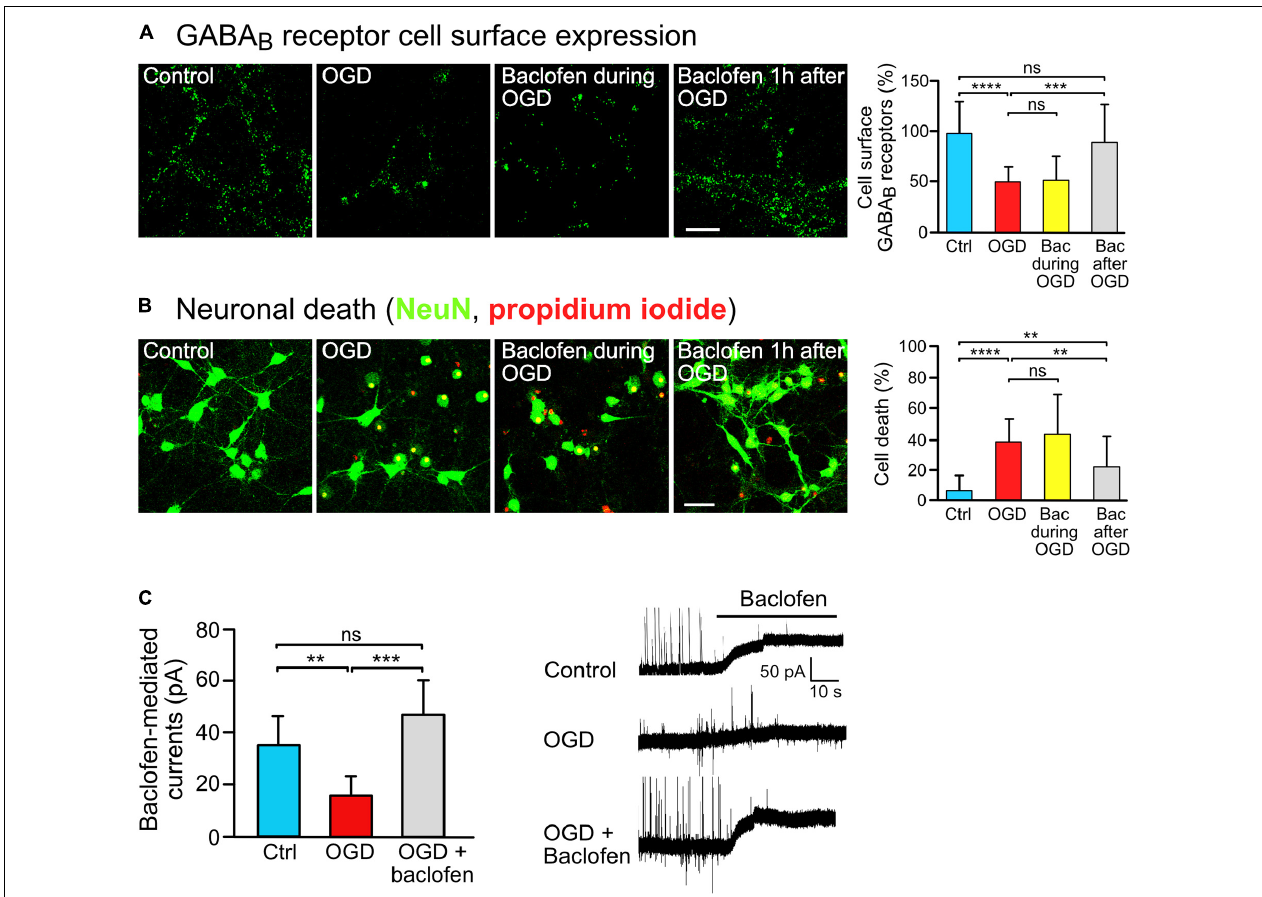
FIGURE 1 | Baclofen treatment restored GABA B receptor surface expression and was neuroprotective after OGD stress in vitro . (A) Baclofen treatment after, but not during, OGD increased GABA B receptor cell surface expression. Cultures were treated with baclofen (50 µ M) during or after OGD. After 16 h after OGD, neurons were then analyzed for the level of GABA B receptor surface expression using antibodies directed against GABA B 2 . The incubation time with baclofen was 1 h in the “Bac during OGD” condition and 16 h in the “Bac after OGD” condition. Left, representative images (scale bar, 10 µ m). Right: the bar graph depicts the quantification of fluorescence intensities. The data represent the mean ± SD of 18–23 neurons per condition from two independent experiments. One-way ANOVA followed by Tukey’s Multiple Comparison test (ns, p > 0.05; ***, p < 0.001; ****, p < 0.0001). (B) Treatment with baclofen after, but not during, OGD reduced neuronal loss in vitro . Cultures were treated as in panel (A) and neuronal loss was determined using propidium iodide (red) and NeuN staining (green) 24 h after OGD. Left, representative images (scale bar, 40 µ m). Right: the bar graph depicts the quantification of fluorescence intensities. The data represent the mean ± SD of 40–41 neurons per condition from three independent experiments. One-way ANOVA followed by Tukey’s Multiple Comparison (ns, p > 0.05; **, p < 0.01; ****, p < 0.0001). (C) Baclofen treatment normalized GABA B receptor mediated currents in OGD-stressed neurons. Cultured neurons were subjected to OGD and treated or not for 16 h with baclofen. After washing to remove baclofen, baclofen-induced currents were measured for a duration of 10 min using whole cell voltage clamp recordings. Right, representative voltage clamp traces. The data represent the mean ± SD of 6–9 neurons per condition from two independent neuron preparations. One-way ANOVA with Tukey’s Multiple Comparison post hoc test (ns, p > 0.5; **, p < 0.01; ***, p <